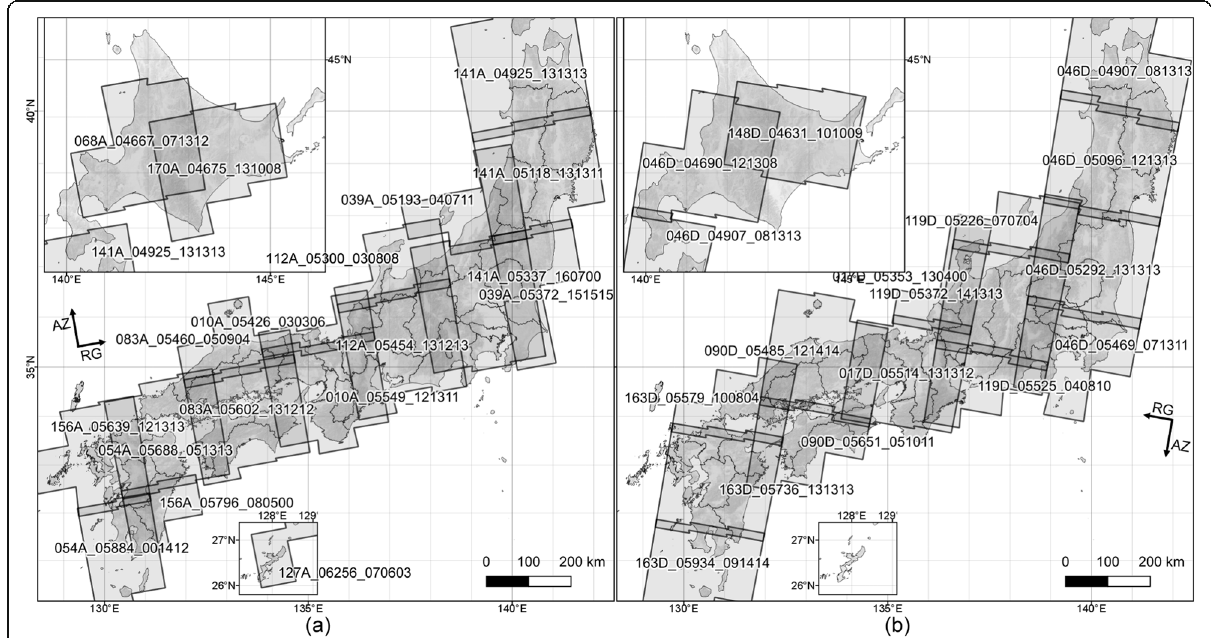
Fig. 1 Footprints of Sentinel-1 LiCSAR frames over Japan. a Ascending. b